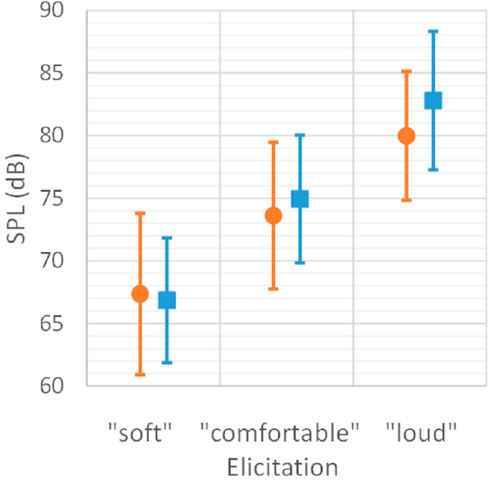
Figure 3. Means and standard deviations in SPL, by elicitation of sustained /a/ vowels in two cohorts. Round markers: cohort 1, male ( N = 42) and female ( N = 50) healthy young speakers, from [40]. Square markers: cohort 2, female voice patients ( N = 85) at baseline prior to intervention [16]. The mean SPL of elicited productions differed by 6–8 dB per level, with a standard deviation of ±5–7 dB.